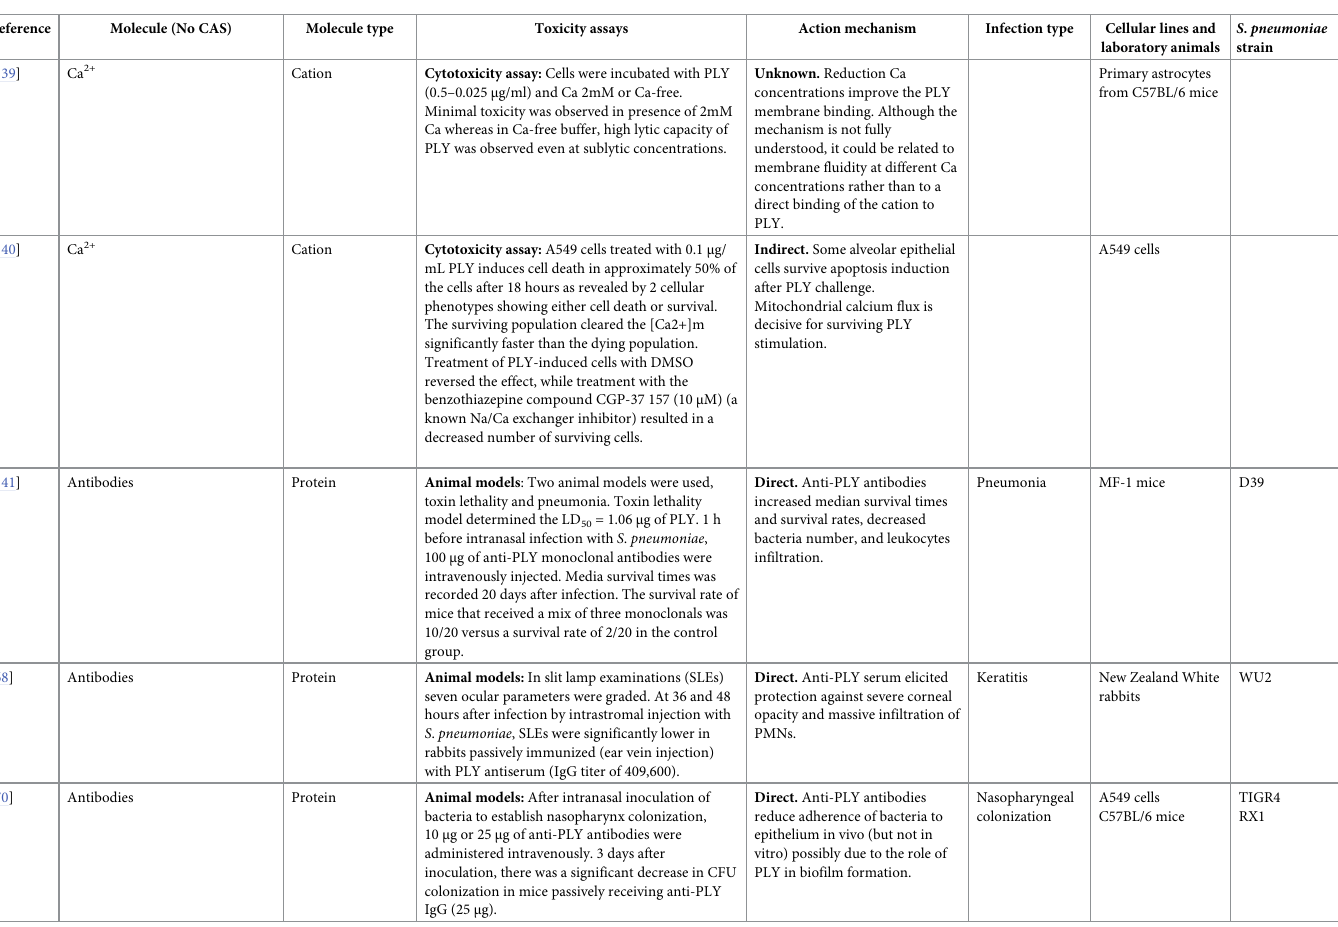
Animalmodels: Inslitlampexaminations(SLEs) sevenocularparametersweregraded.At36and48